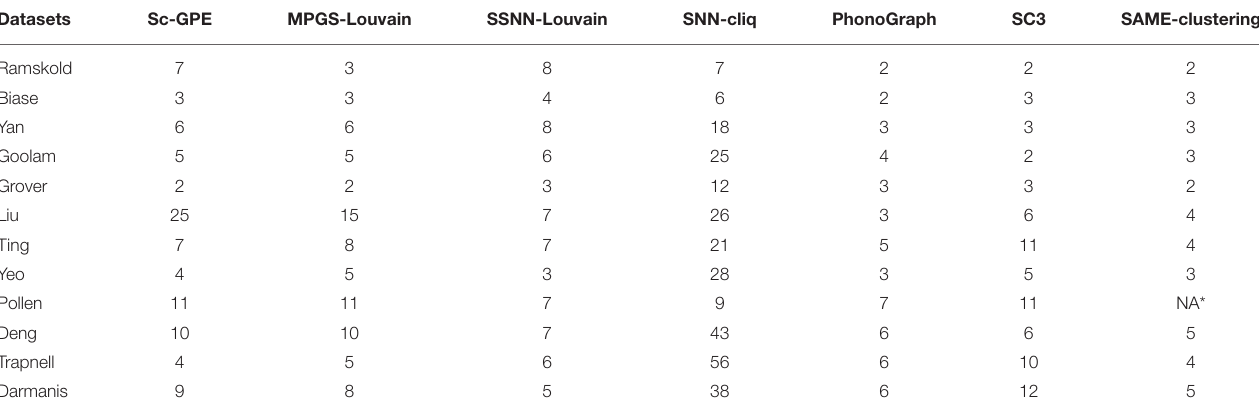
TABLE 2 | The comparison of the number of clusters from seven methods.